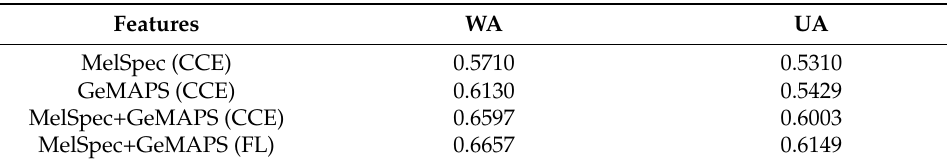
Table 1. Recognition accuracy for four experimental settings.